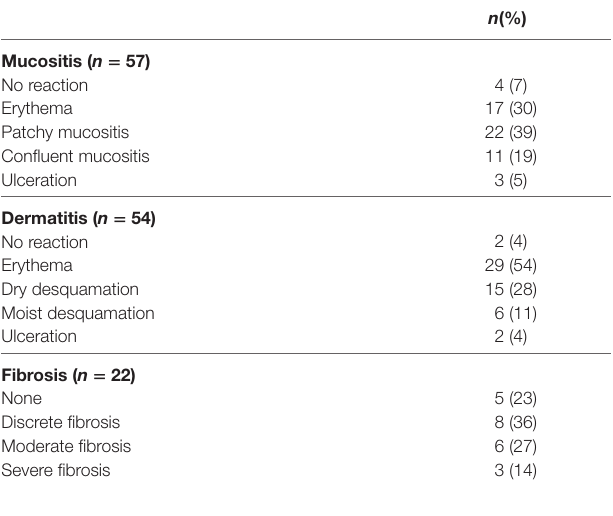
TaBle 3 | Highest degree of mucositis and dermatitis registered and highest degree of fibrosis at any time past 2 months posttreatment.